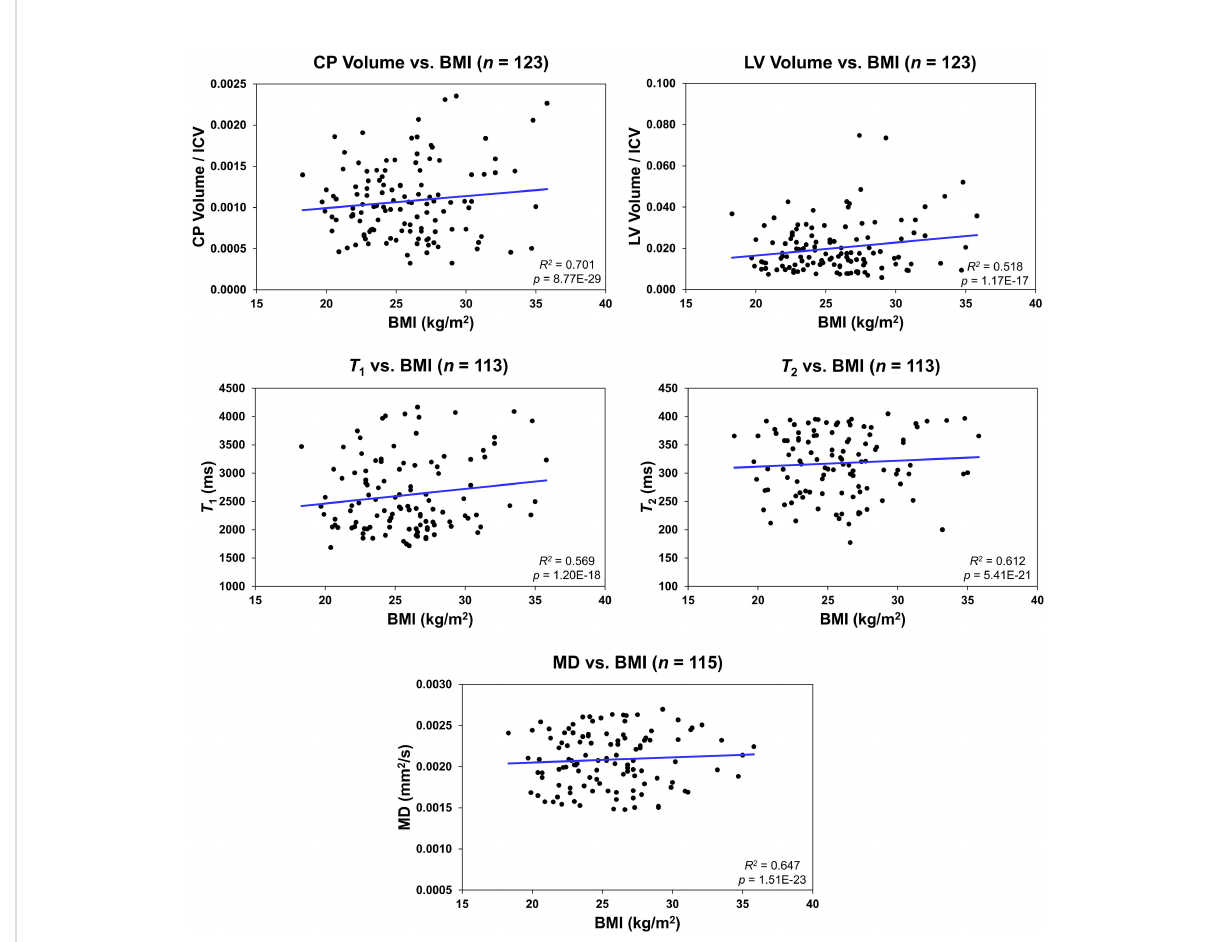
FIGURE 2 Regression results for the relationship between the lateral ventricle (LV) volume/intracranial volume (ICV), T 1 , T 2 , or mean diffusivity (MD) and body mass index (BMI) adjusted for age, age 2 , sex, and ethnicity. For the choroid plexus (CP) volume/ICV, regression results were controlled for age, age 2 , sex, ethnicity, and LV volume. The coef fi cient of determination, R 2 , and p-value, p , of the multiple linear regression model are reported. The CP volume, LV volume, T 1 , T 2 , or MD exhibited signi fi cant positive correlations with